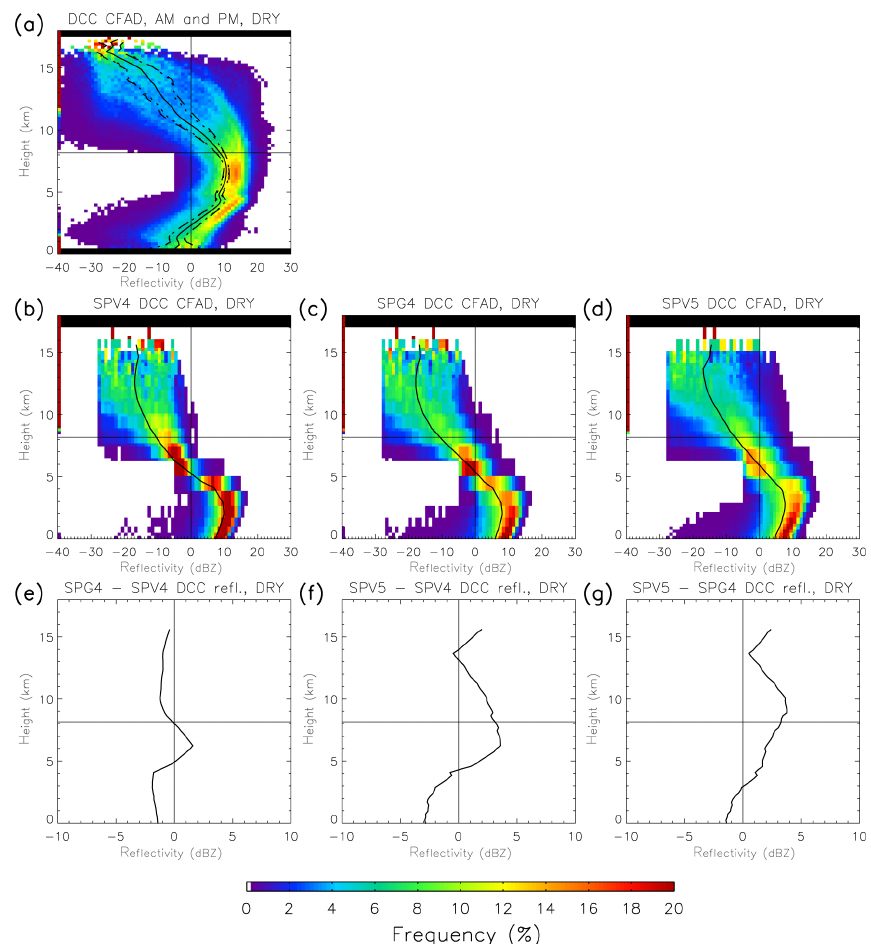
Figure 6. (a, b, c, d) CFADs of dry season DCC reflectivity in Amazonia from (a) CloudSat, (b) SPV4, (c) SPG4 (i.e., SPV4 with diagnosed graupel included), and (d) SPV5, as in Fig. 4. (e, f, g) The difference of the mean vertical reflectivity profile between (f) SPG4 and SPV4, (f) SPV5 and SPV4, and (g) SPV5 and SPG4.